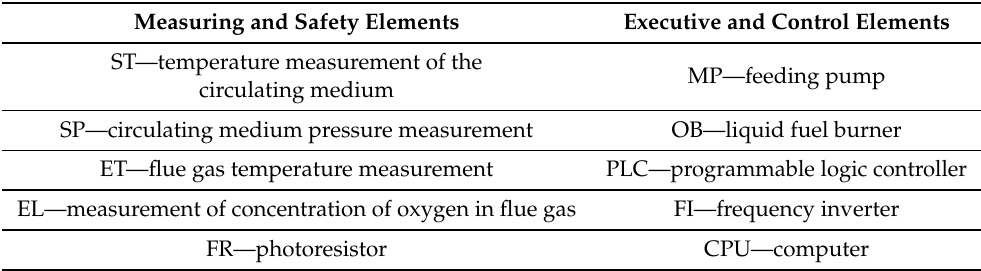
Table 1. Description of measuring and control elements of the biomass steam